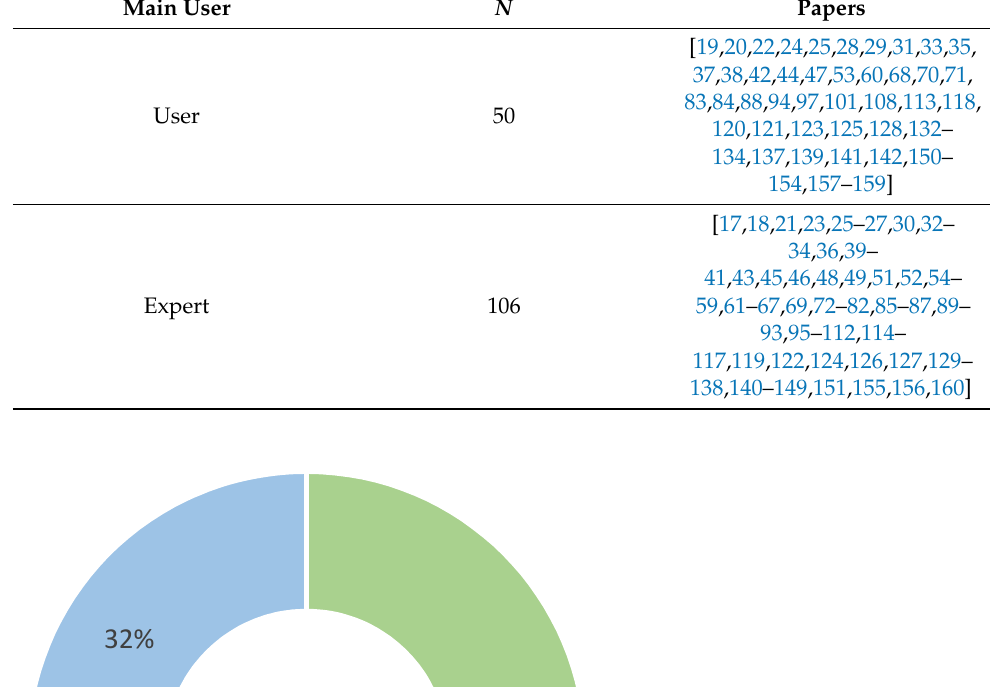
Table 9. Primary users of BMF system.